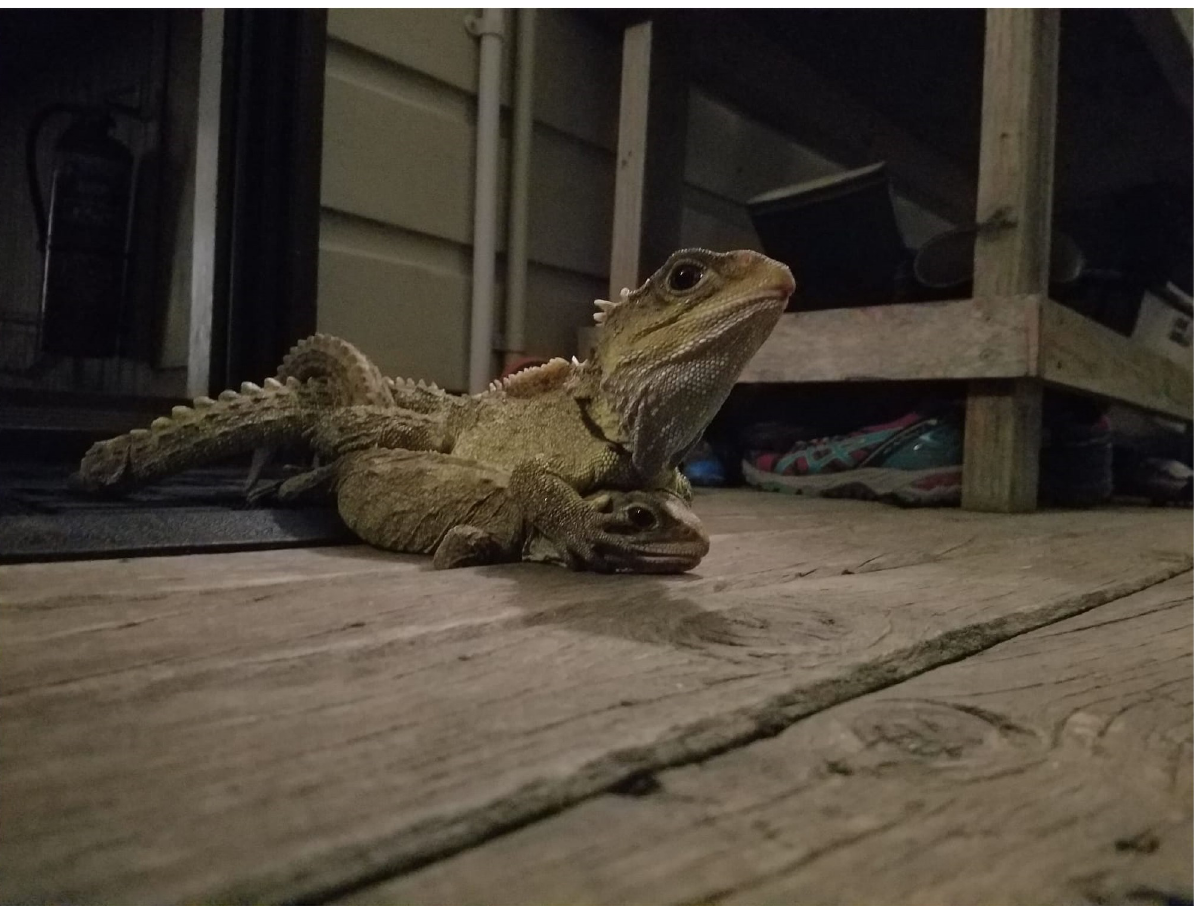
Fig 2. Tuatara ( Sphenodon punctatus) mating. Tuatara mating on the porch of a Department of Conservation ranger house on Takapourewa. The male is postured on top of the female, with his hind limbs and tail twisting to oppose their cloaca. Tuatara are unique among reptiles for their lack of intromittent